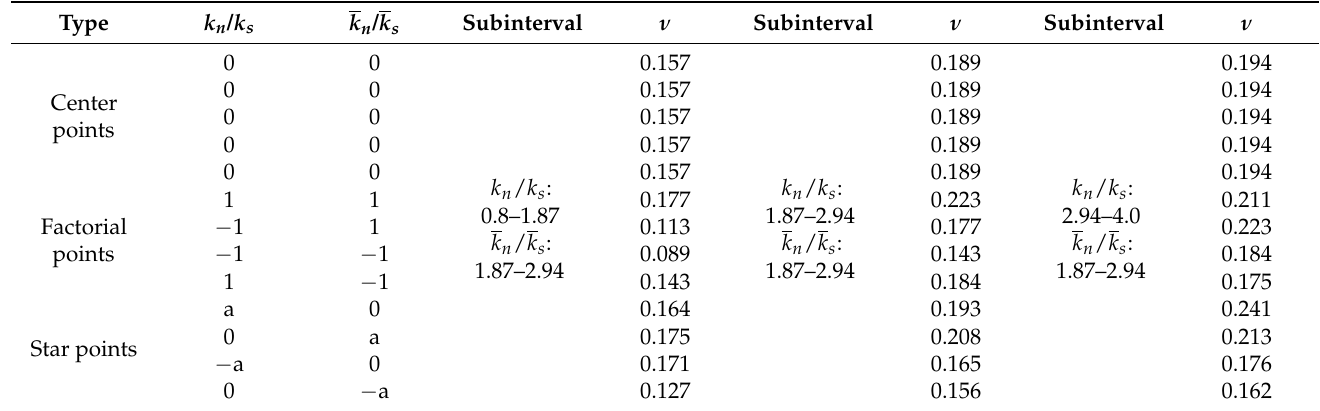
Table 6. CCD test scheme and calculation results of Poisson’s ratio.